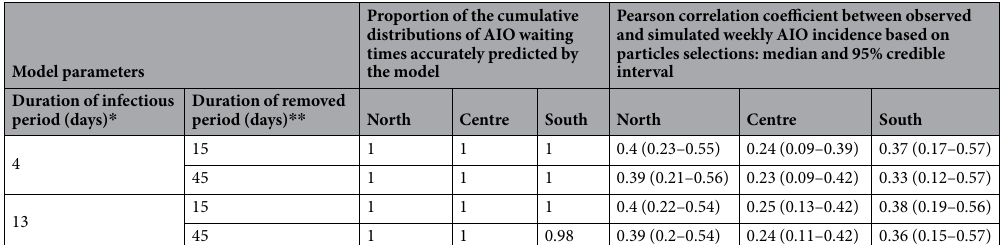
Pearson correlation coefficient between observed and simulated weekly AIO incidence based on